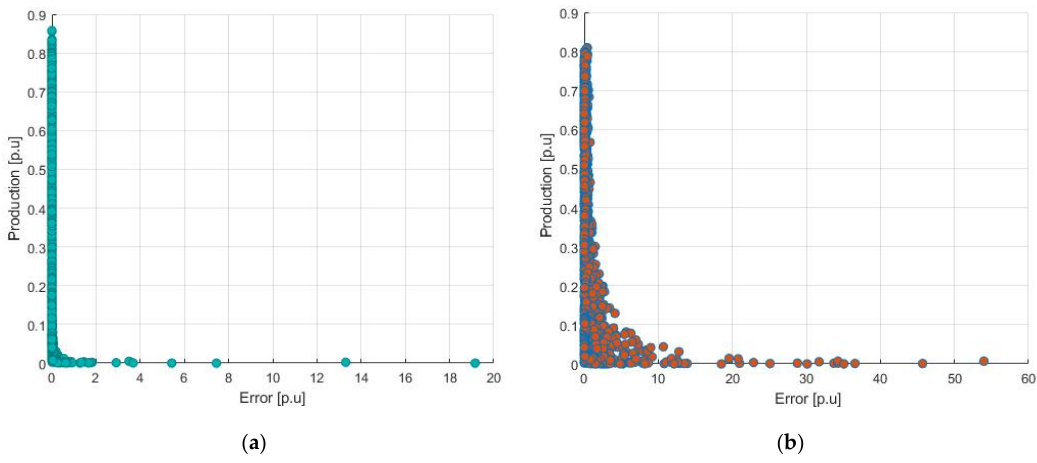
Figure 7. Absolute relative hourly error with respect to the production, as a function of the production. ( a ) Results for Plant 1; ( b ) results for Plant 2.